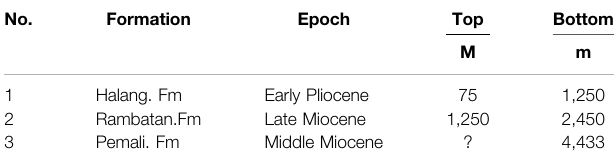
TABLE1| FaciesanalysisbasedonJati-1welllogdata(Tampubolonetal.,2014). No. Formation Epoch Top Bottom M m Halang. Fm Early Pliocene 75 1,250 2 Rambatan.Fm Late Miocene 1,250 2,450 3 Pemali. Fm Middle Miocene ?